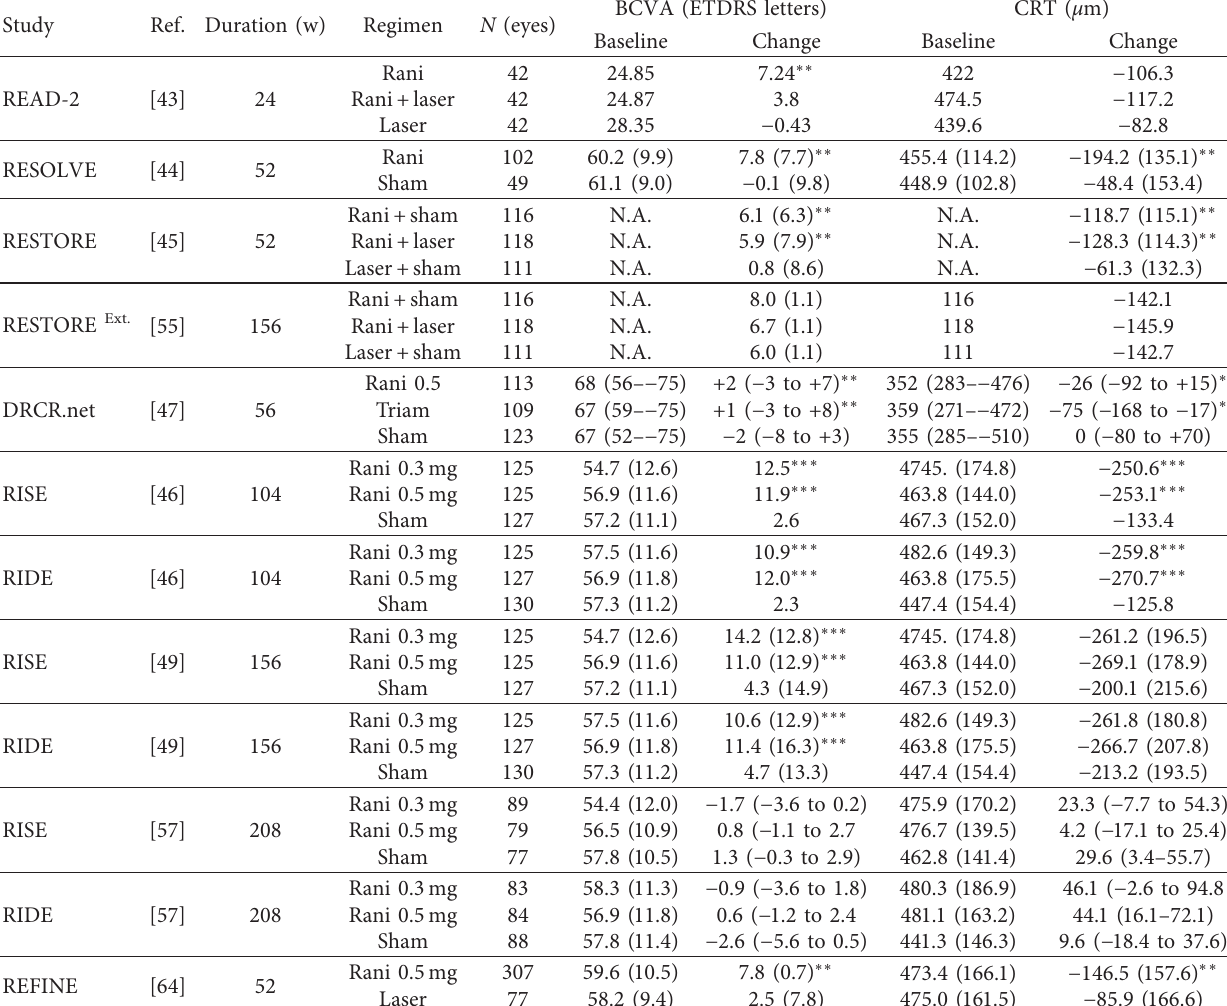
Table 3: Overview of the functional and anatomic results of